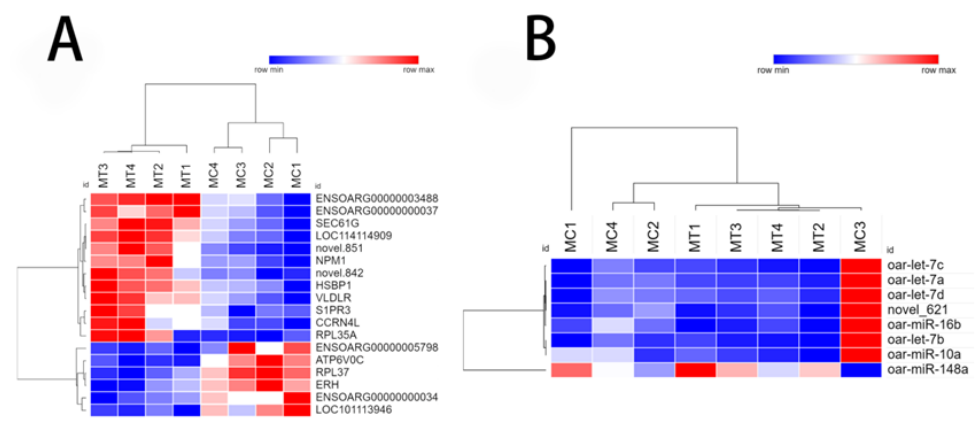
Figure 5. Heat map of differentially expressed mRNA ( A ) and heat map of differentially expressed miRNA ( B ). Significantly different genes and miRNAs clustering heat map. Red and blue represent upregulated and downregulated, respectively.